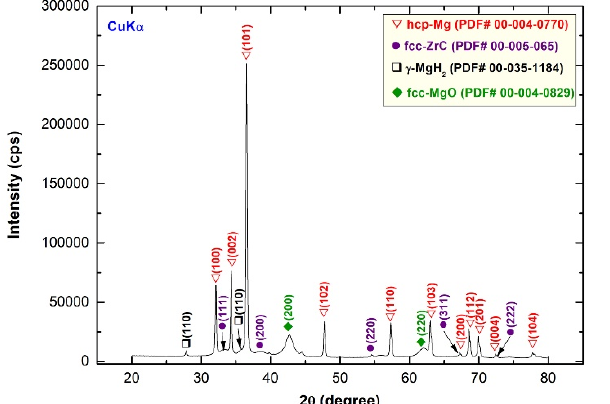
Figure 9. XRD pattern of nanocomposite MgH 2 /5 wt.% ZrC milled for 25 h of HEBM and then heated up to 500 °C in a DSC under the flow of He gas.